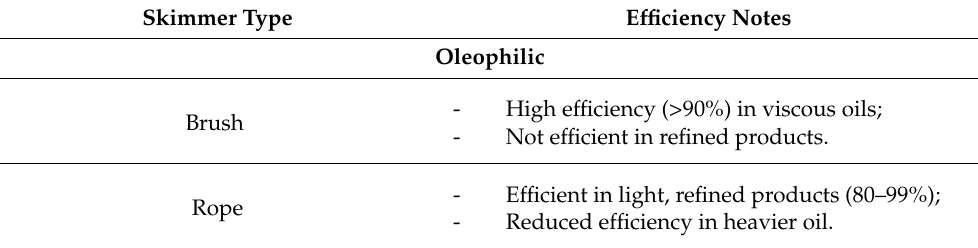
Table 3. The efficiency of skimmers